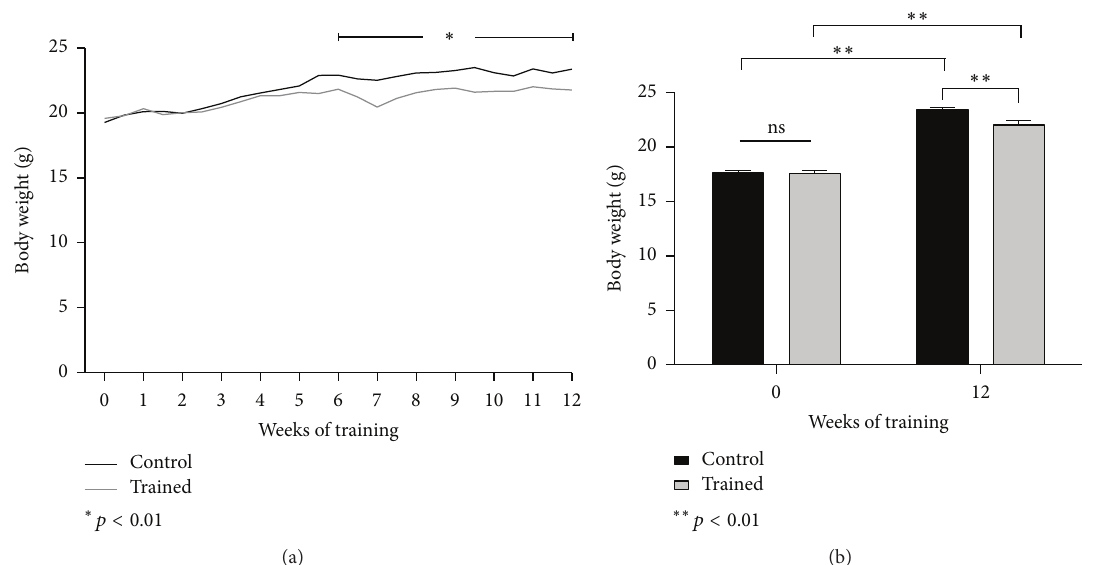
Figure 4: (a) Body weight throughout the 12-week training program. (b) Body weight difference at baseline and upon completion of the 12-week training program. Results are shown as means and